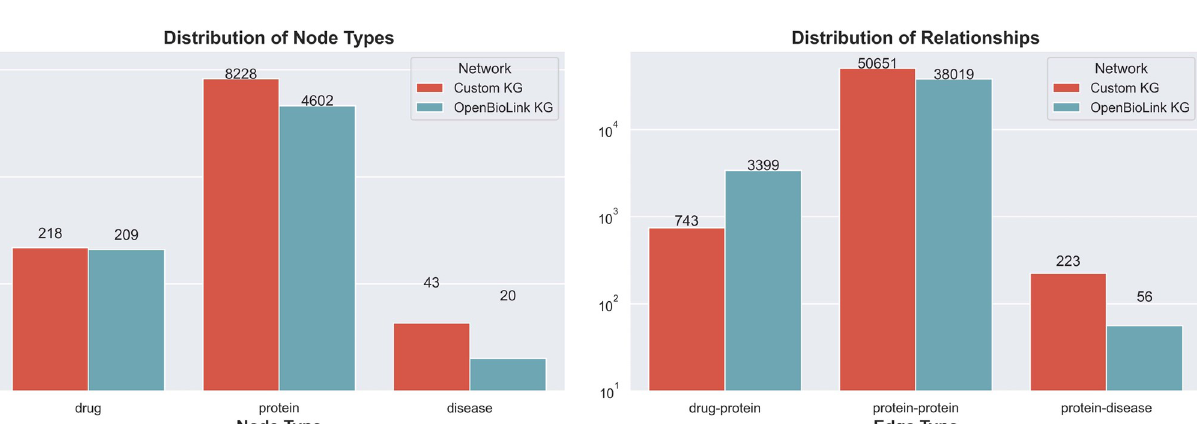
PLOS Computational Biology | https://doi.org/10.1371/journal.pcbi.1009909 February25,